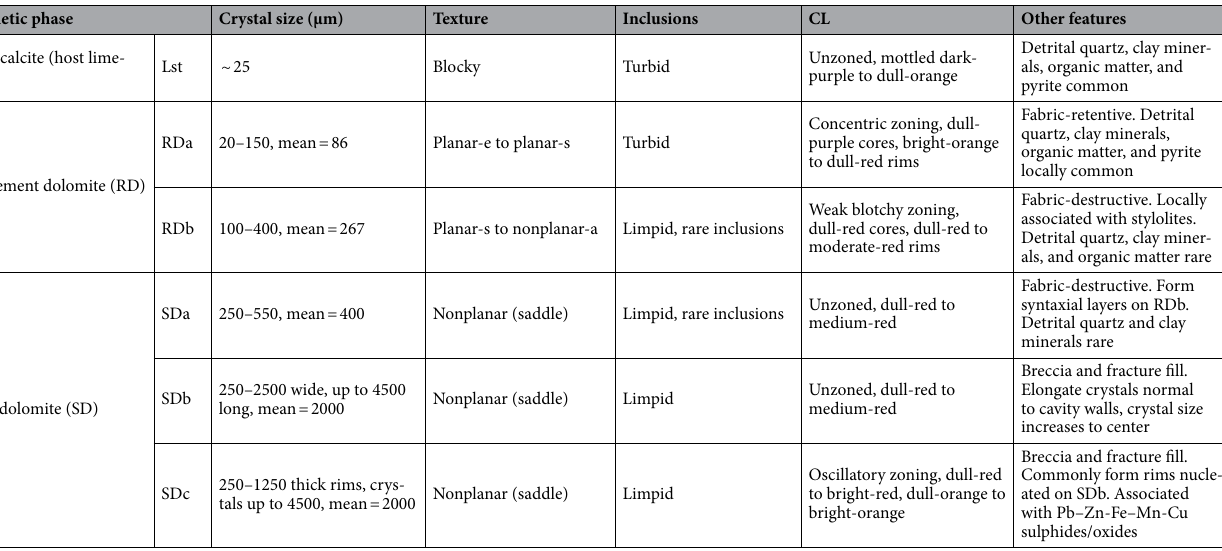
Table 1. Summary table of the microscopic features of the diagenetic phases in the Cathedral Formation at Whirlpool Point, southern Rocky Mountains based on transmitted light, cathodoluminescence (CL), and scanning electron